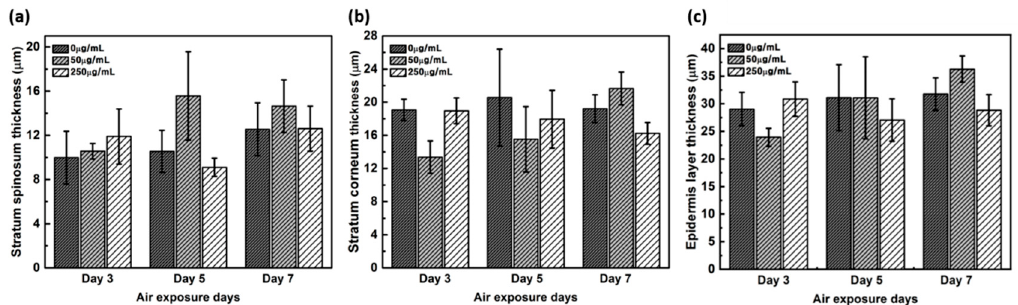
Figure 2. Thickness of ( a ) stratum corneum layer, ( b ) spinosum layer, and ( c ) total thickness of the stratum corneum layer and spinosum layer measured from H&E stained images as a function of air exposure days and concentration of CLLE.